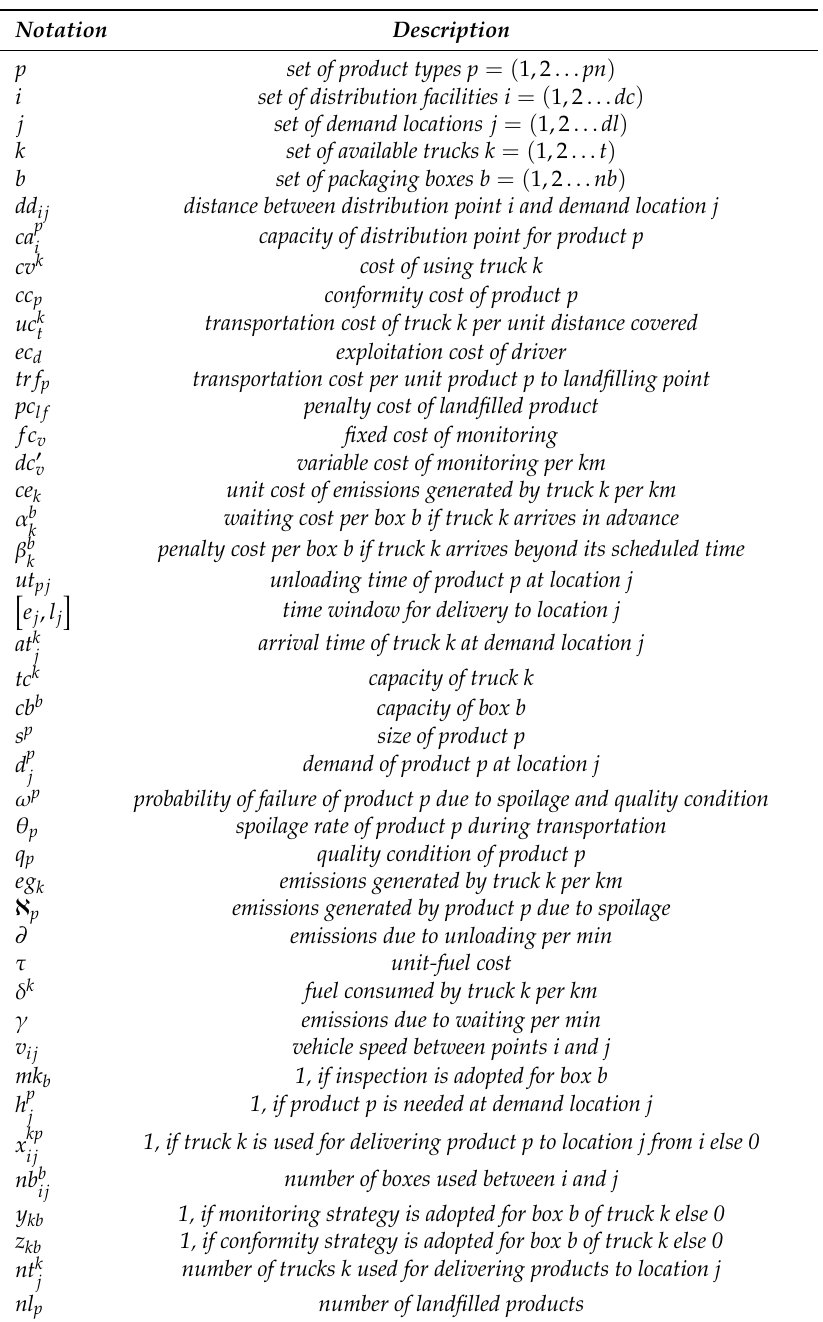
Table 3. Description of model